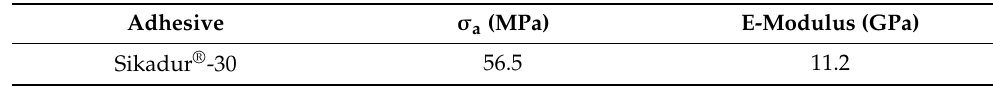
Table 4. The characteristics of the